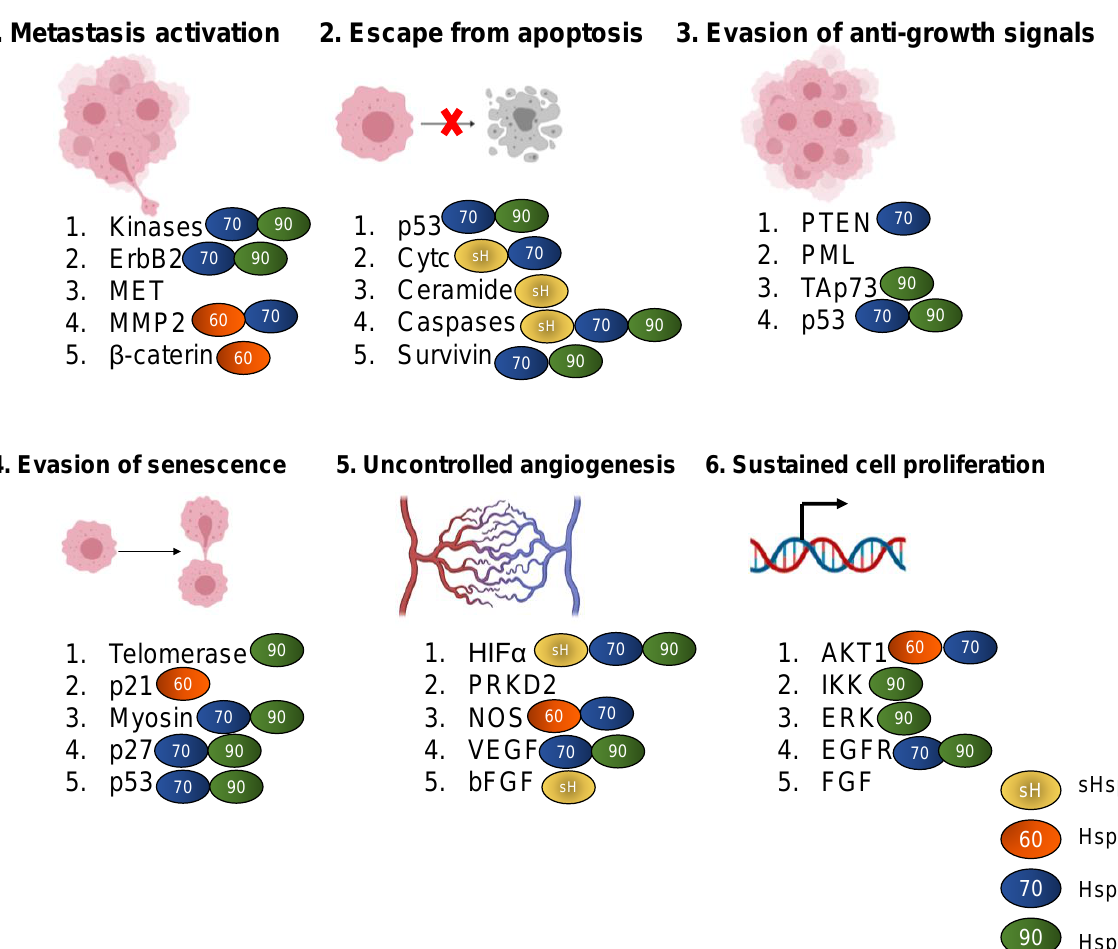
Figure 1. The proteomic landscape of the hallmarks of cancer: The processes of metastasis, uncontrolled angiogenesis, evasion of anti-growth signals, escape from apoptosis, cell proliferation and evasion of senescence are all crucial to tumor cell growth. Each of these processes is regulated by several proteins that play important roles in the respective signaling pathways. As chaperones, sHsps, Hsp70, Hsp90 and Hsp60 associate with several proteins that regulate cancer signaling pathways.